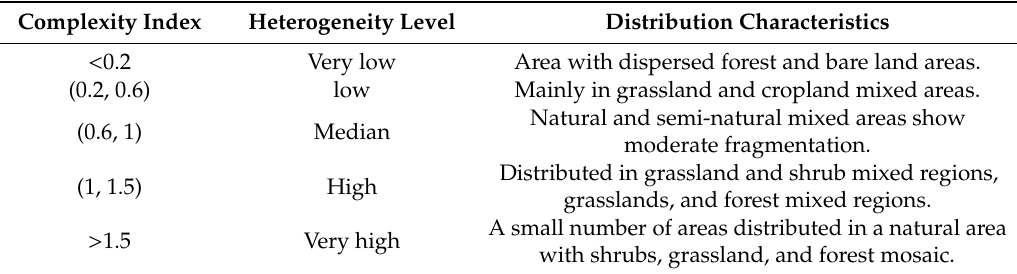
Table 3. Heterogeneity levels of land cover in